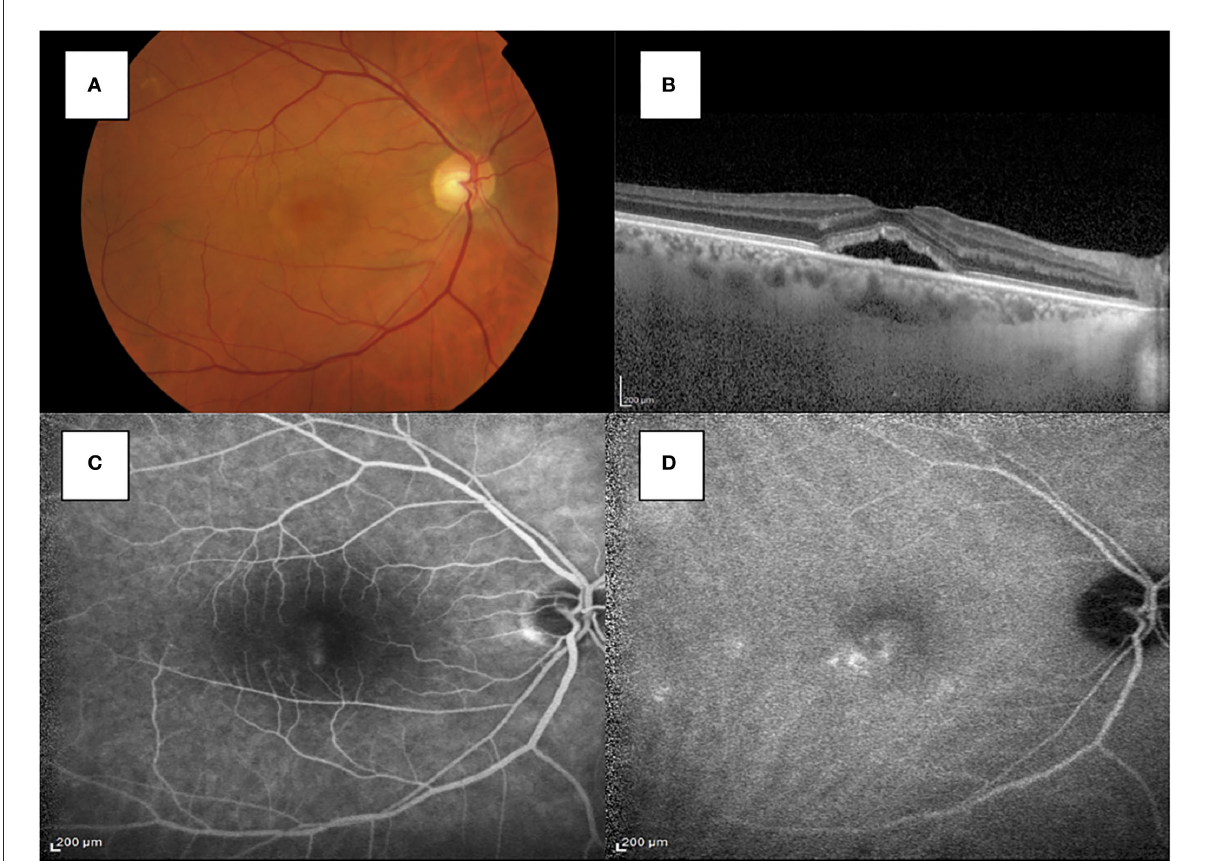
FIGURE2 (A) Fundus photography showed the macular serous retinal detachment in the right eye. (B) SD-OCT shows the accumulation of subretinal fluid in the subfoveal region of the right eye. (C) The FA image showed spots of hyperfluorescence with a smokestack pattern in the late stage. (D) ICGA showed multiple spots of hypercianescence in the macular